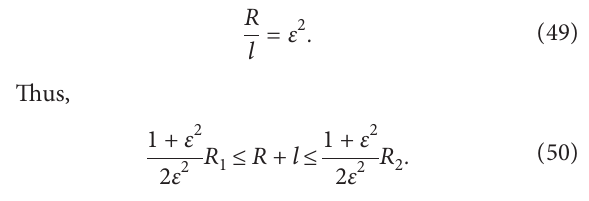
10 in the input shaft of the gearbox in the